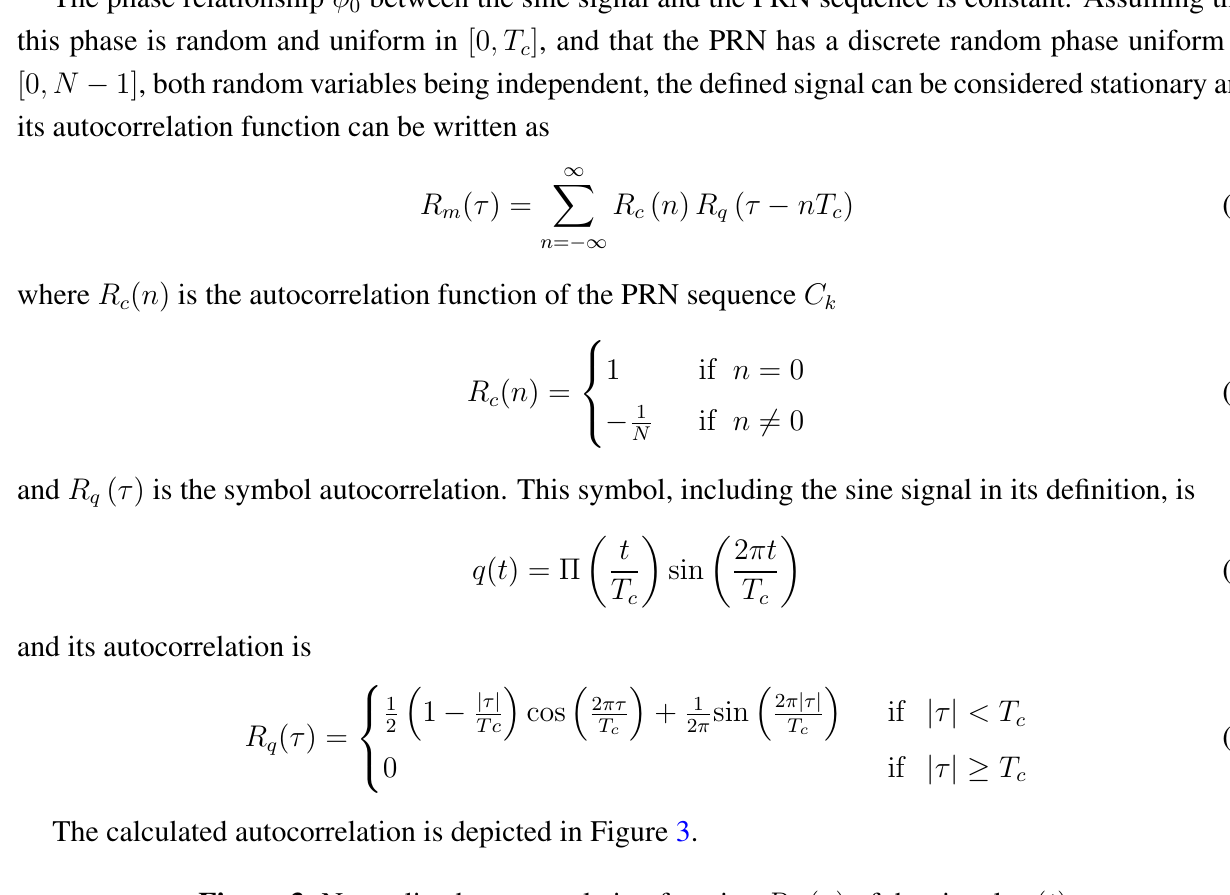
Figure 3. Normalized autocorrelation function R